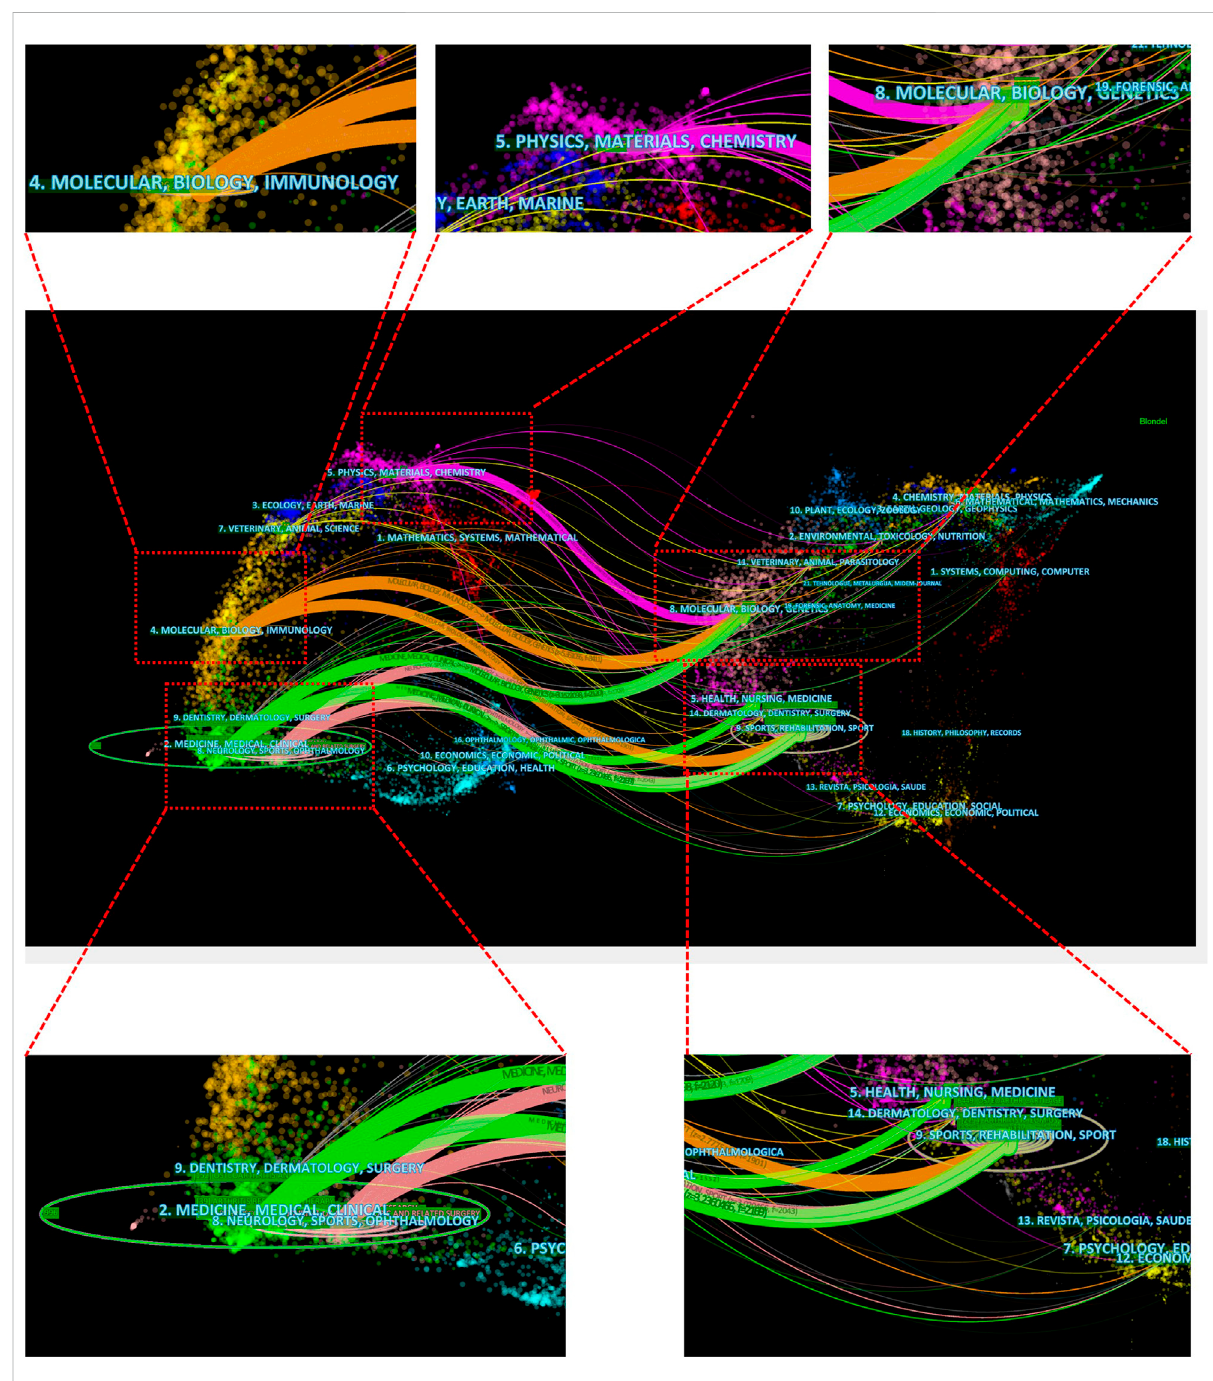
FIGURE 7 The dual-map overlay of journals related to HA for the treatment of OA based on CiteSpace.